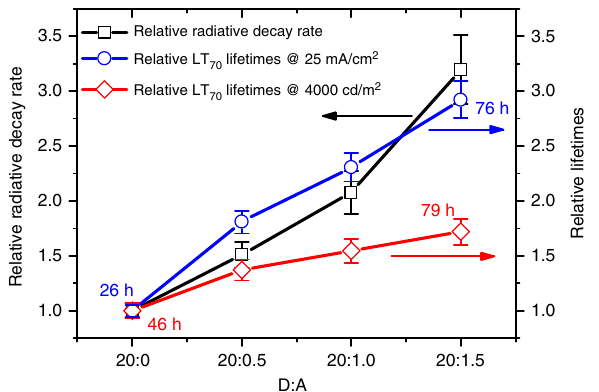
Fig. 5 Correlation between lifetimes and radiative decay rates. Comparison of the relative radiative decay rates (black) and relative lifetime values (70% decay, LT 70 ) as a function of acceptor concentration. The device lifetimes were measured at constant current with initial current density of 25 mA/cm 2 (blue) and initial luminance of 4000 cd/m 2